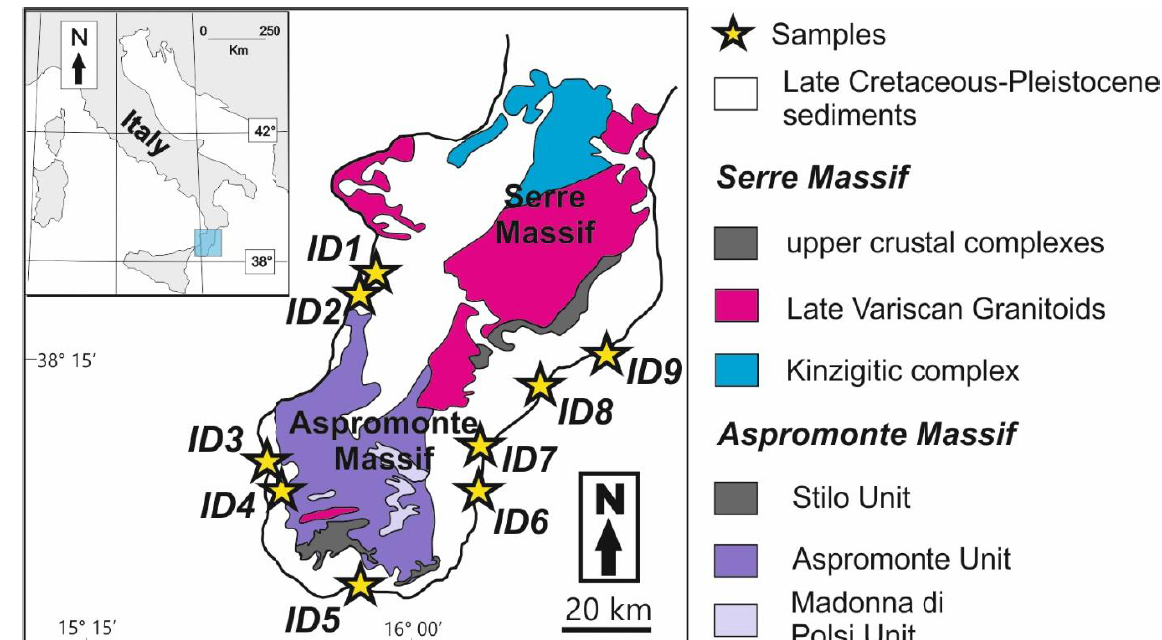
Figure 1. Geological sketch map of central-southern Calabria; yellow stars: sampling sites.